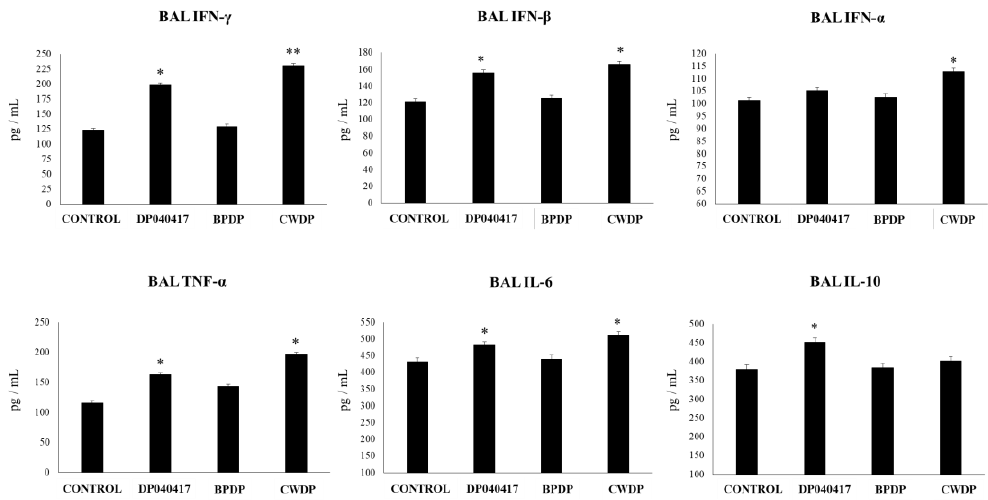
Figure 8. Effect of Dolosigranulum pigrum 040417 on respiratory cytokines after the nasal administration of the viral pathogen-associated molecular pattern poly(I:C). Infant mice were nasally primed with viable (DP), bacterium-like particles (BPDP) or cell wall (CWDP) from D. pigrum 040417 during five consecutive days and then challenged with three once-daily doses of poly(I:C). Non- treated infant mice challenged with poly(I:C) were used as controls. Two days after the last poly(I:C) administration the levels of tumor necrosis factor (TNF)- α, interferon (IFN) - α, IFN - β, IFN - γ, interleukin (IL)-6, and IL-10 were determined in broncho-alveolar lavages (BAL). Experiments were performed with 5 – 6 mice per group. The results represent data from three independent experiments. Significantly different when compared to control * p < 0.05 or ** p < 0.01.